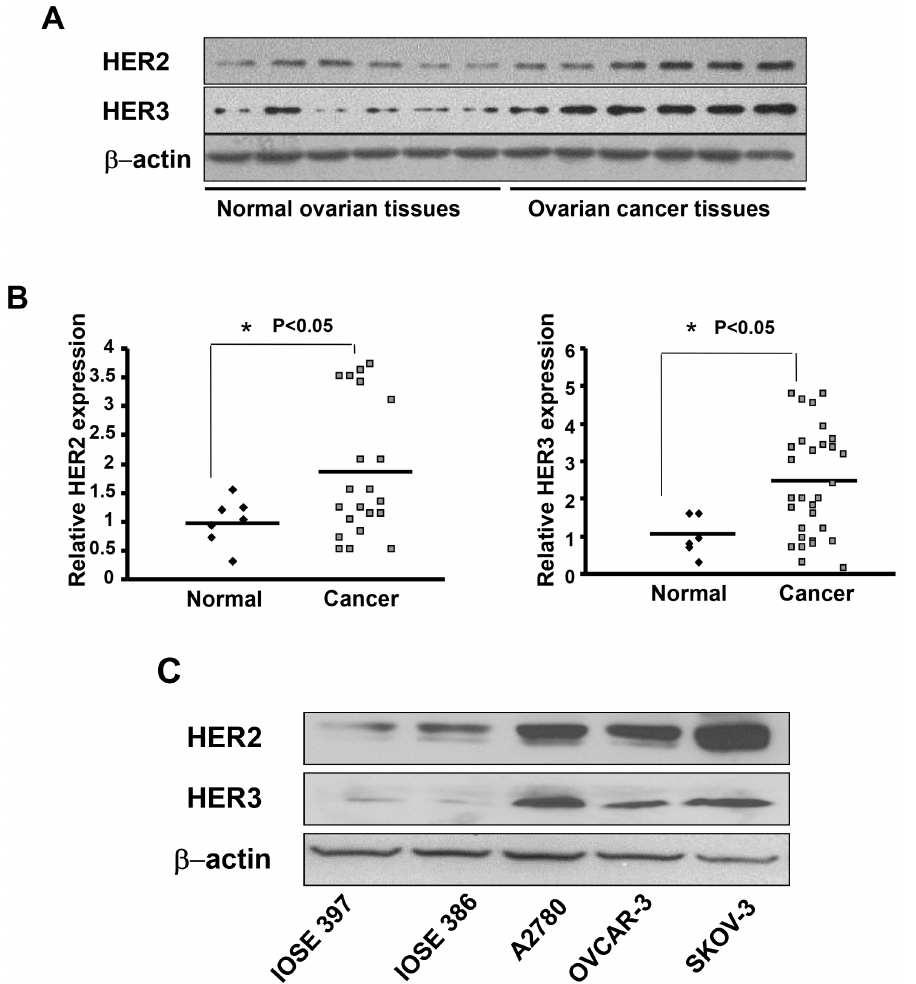
Figure 3. HER2 and HER3 protein expression levels in ovarian cancer tissues. (A) The protein levels of HER2 and HER3 were evaluated in human ovarian cancer tissues and normal ovarian tissues by immunoblotting (6 representatives HER2 or HER3 positive samples are shown for both groups). The level of b -actin was used as loading control. (B) Scanning densitometry was used to quantify the relative expression levels of HER2 or HER3. The scattered graphs showed HER2 or HER3 expression levels in HER2 or HER3 positive samples in normal tissues and cancer tissues. The values were normalized to the average value of normal tissues. (C) Expression levels of HER2 and HER3 in ovarian cancer cell lines SKOV3, A2780, OVCAR-3, and immortalized ovarian epithelial cell lines IOSE397, IOSE396 were analyzed by